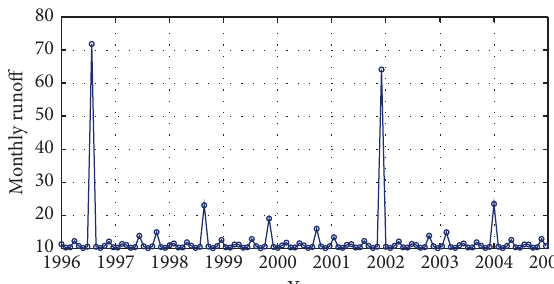
Figure 8: Simulation results of monthly runoff in Jianchang field (1996 ∼ 2005).